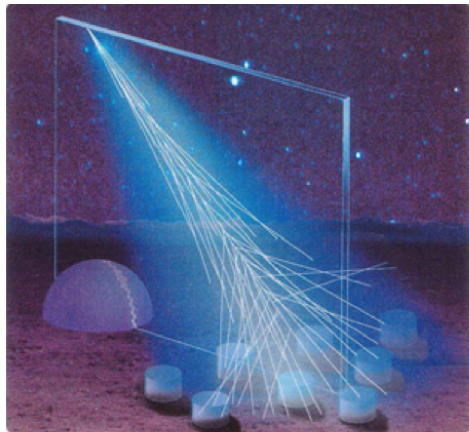
Figure 1. Schematic view of arrays of detectors and large-field- of-view fluorescence telescopes, detecting signals from EAS in- duced by UHECRs [https: //